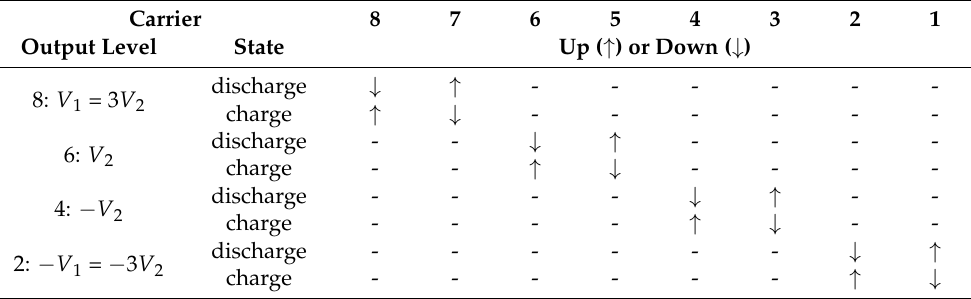
Table 4. Fine tuning correction of the modulation